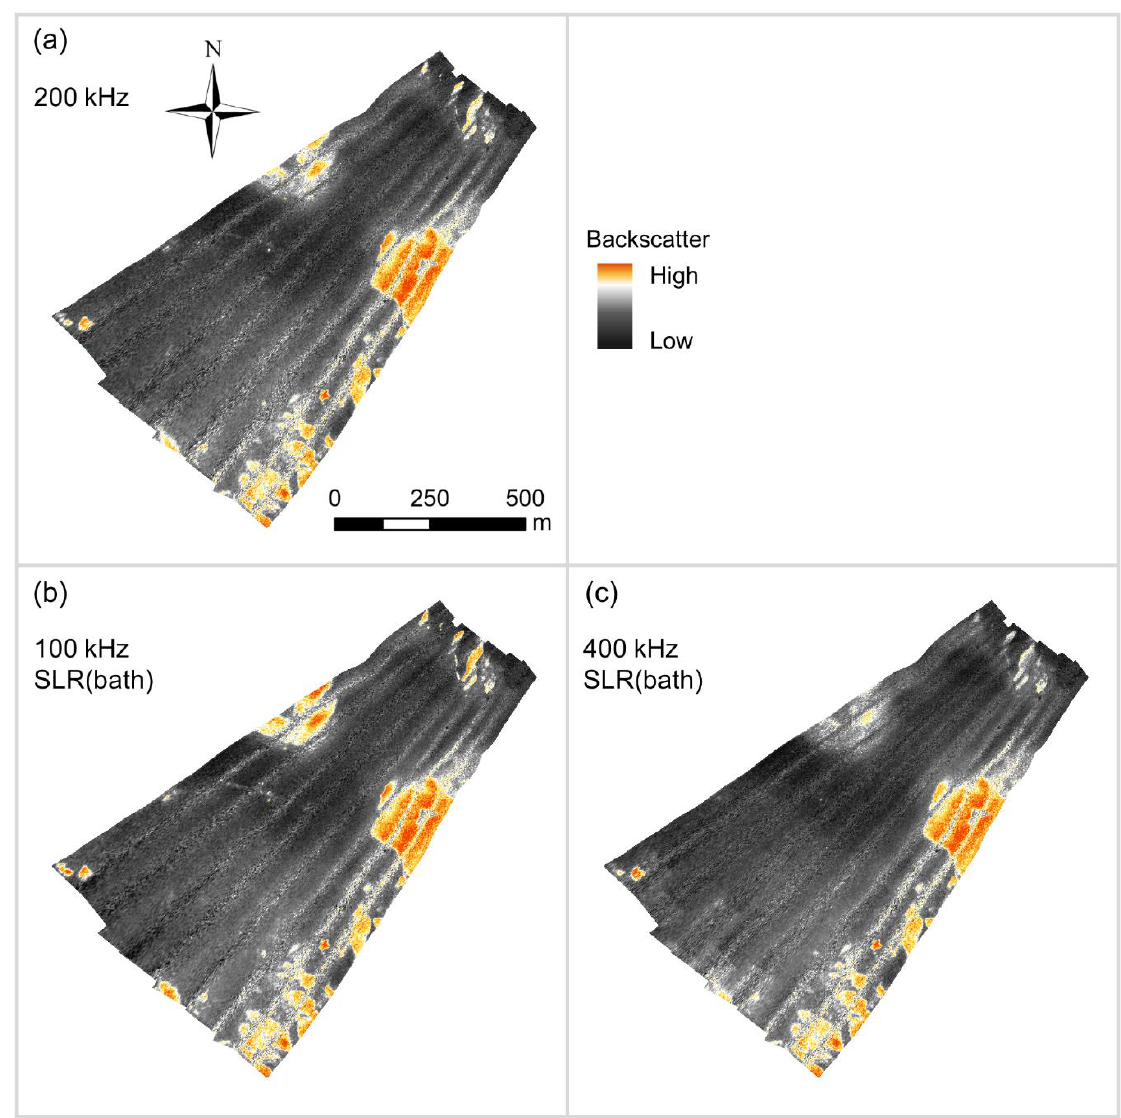
Figure A6. Highest quality bulk shift mosaics of ( a ) the Patricia Bay 200 kHz dataset, with ( b ) 100 kHz, and ( c ) 400 kHz datasets.